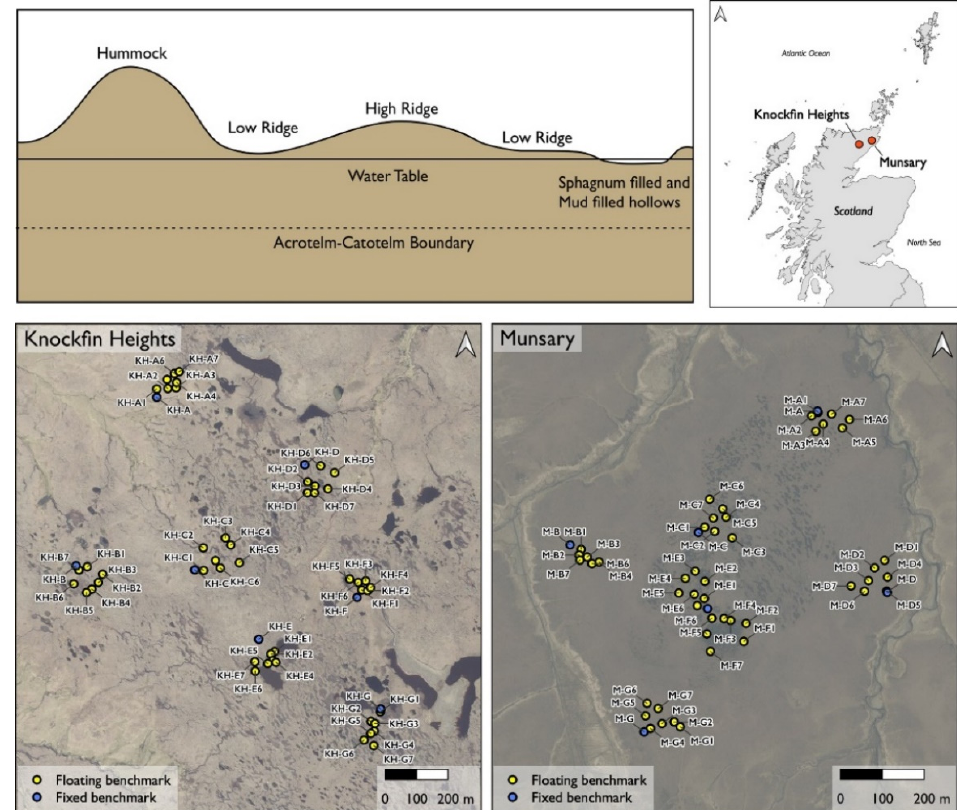
Figure 1. Detailed map of focus areas at Knockfin Heights and Munsary including benchmark locations. ( Bottom Left and Right ) Overview map of the Flow Country ( Top Right ) Site Layout ( Top Left ) Schematic Diagram of the microtopographic classification used after Lindsay 1988.